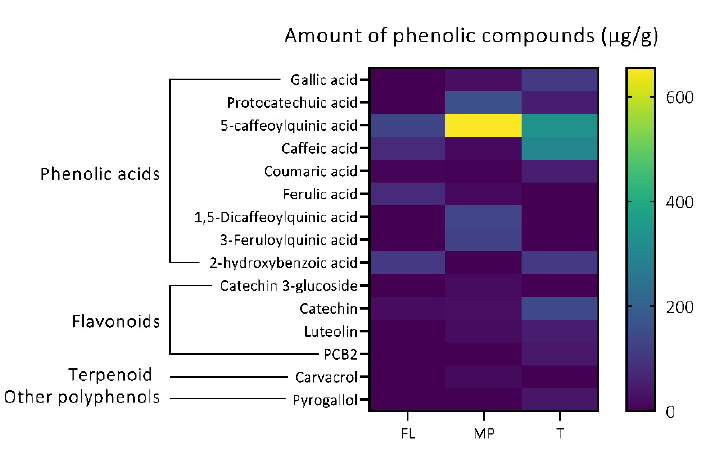
Figure 1. Heatmap of the concentration of bioactive compounds ( μ g/g) in finger lime (FL), mountain pepper (MP), and tamarind (T).